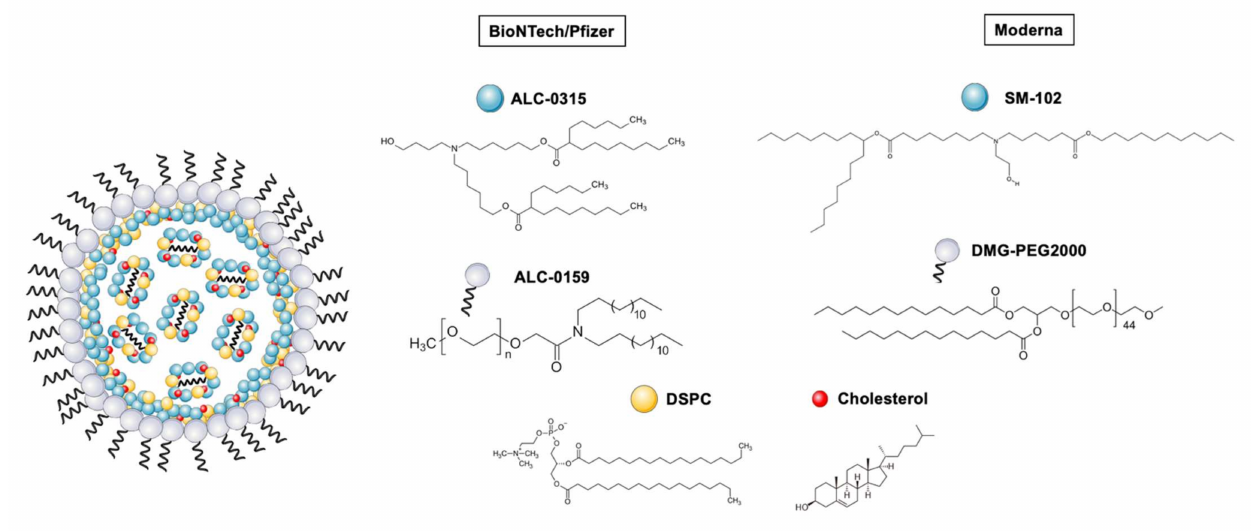
Figure 1. Structure and composition of the authorized COVID-19 mRNA